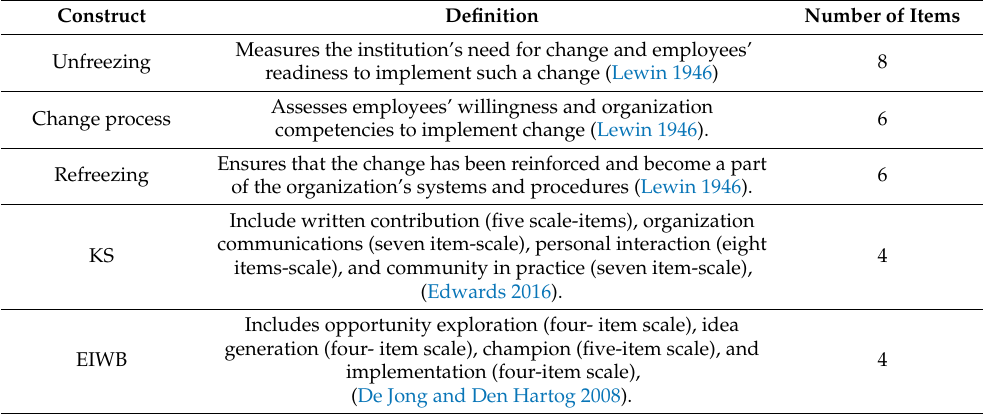
Table 1. Definitions of constructs and